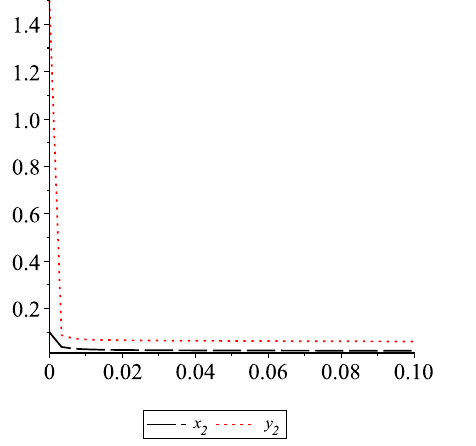
Figure 2: Graphs of second components of the solutions of both the slave and the master delay Caputo fractional system ( 21 ) , ( 20 ) .